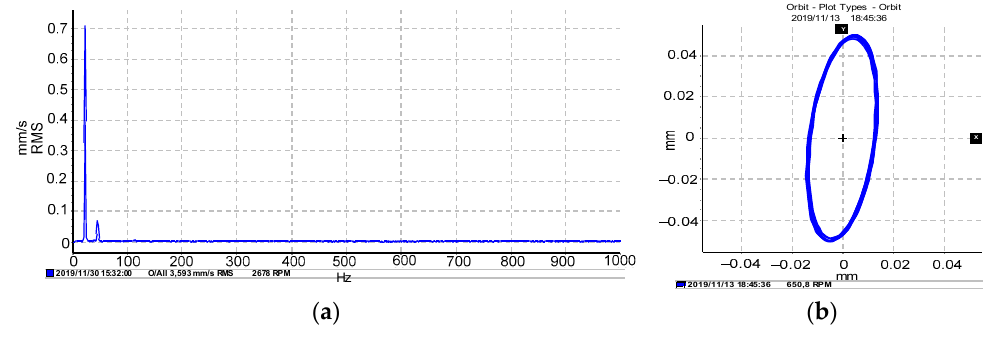
Figure 5. Rotor balance: ( a ) Frequency response; ( b ) rotor orbit